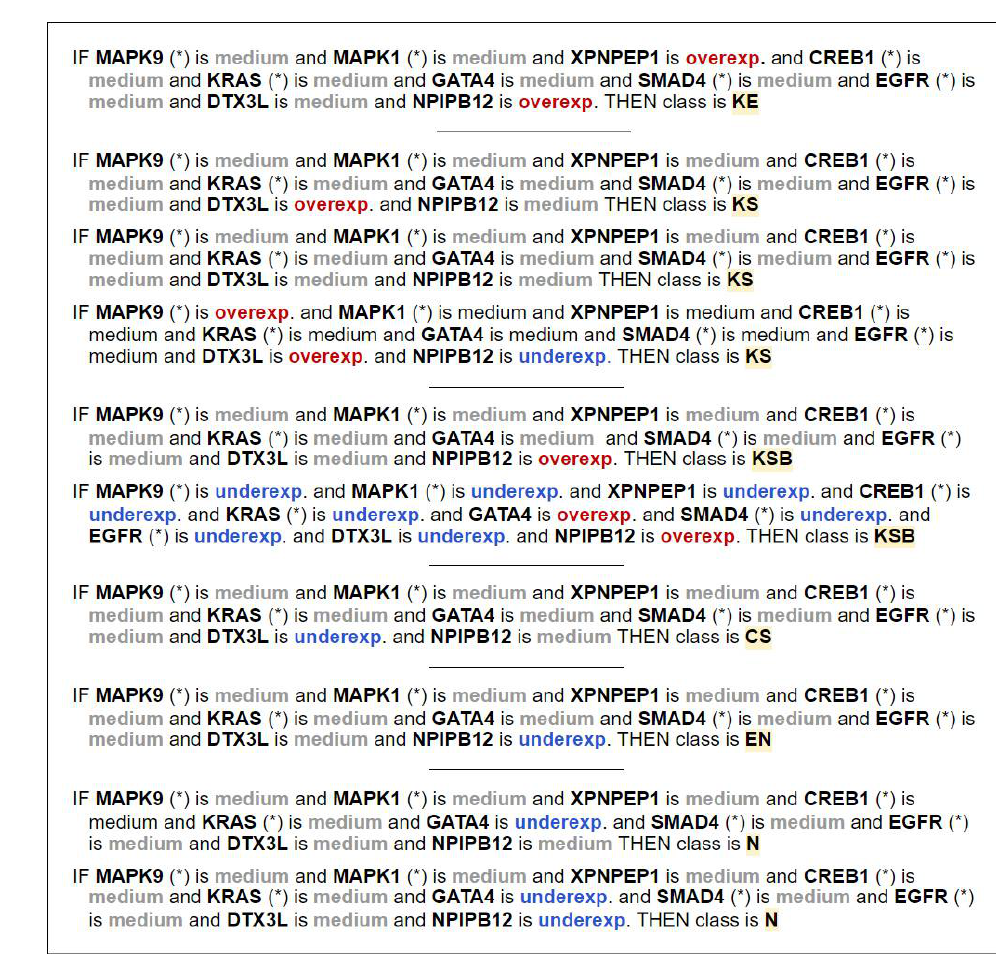
Figure 2. A set of fuzzy rules with accuracy = 100%, able to classify and describe the samples correctly.